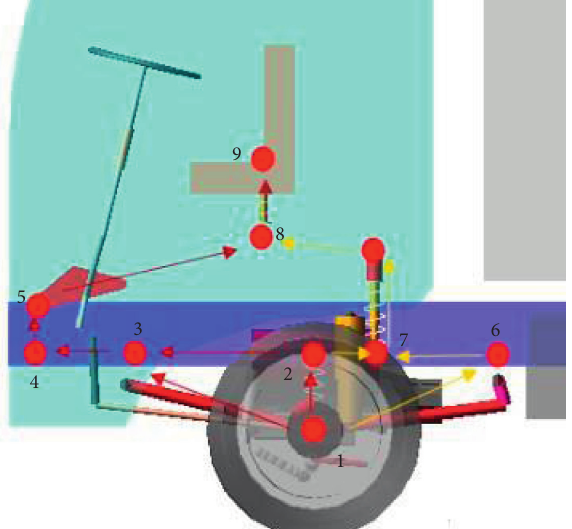
Figure 3: Vibration transfer path from tyre excitation. 1-tyre centre, 2-the upper suspension fulcrum, 3-the leaf spring front fulcrum, 4-front mount lower fulcrum, 5-front mount upper fulcrum, 6-plate spring rear fulcrum. 7-cab suspended lower ful- crum, 8-cab centre of mass, and 9-driver’s centre of mass.